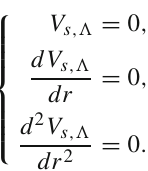
which is the same as in [50,56], corresponding to the zero (cid:2)